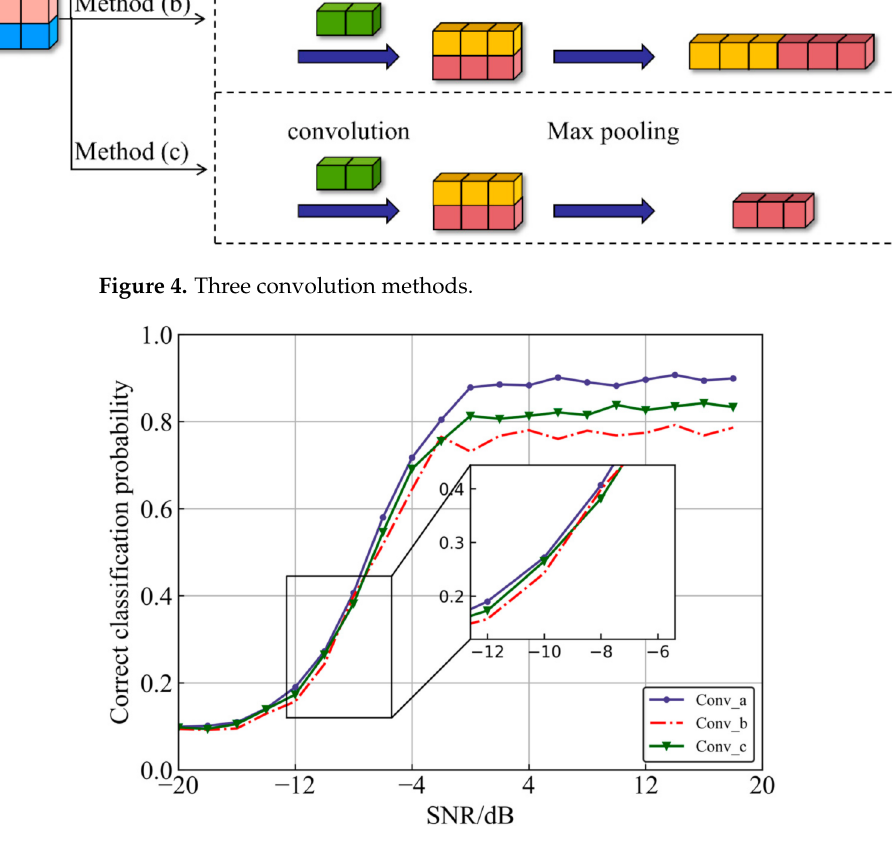
Figure 5. Results of different convolution